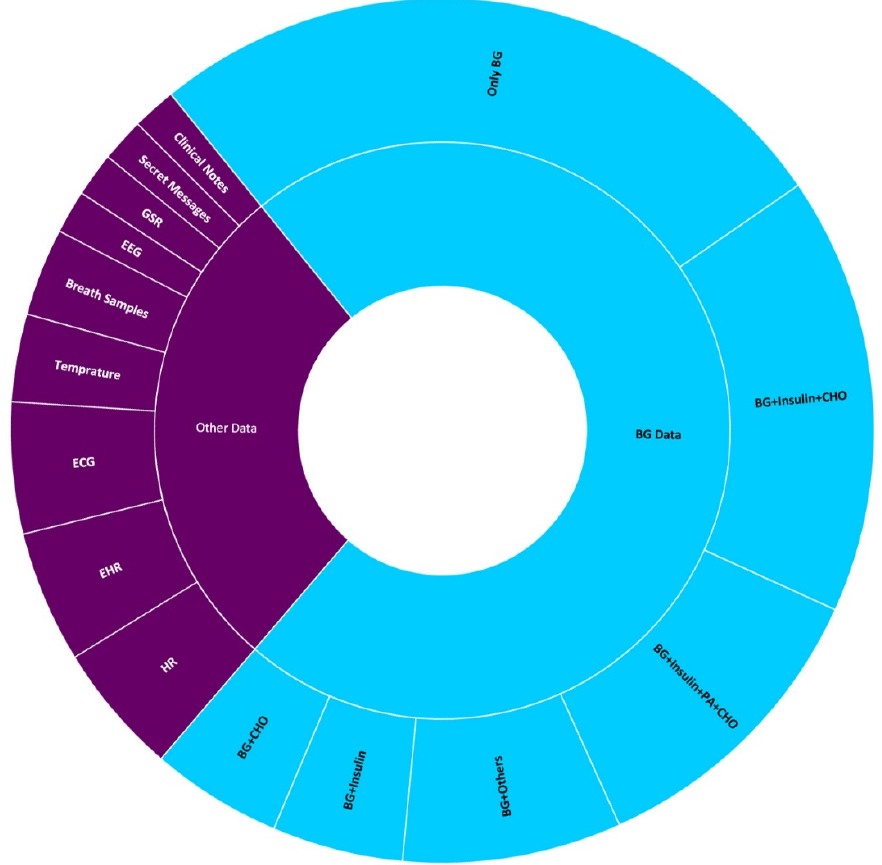
Figure 2. Different types of data used to train ML models.